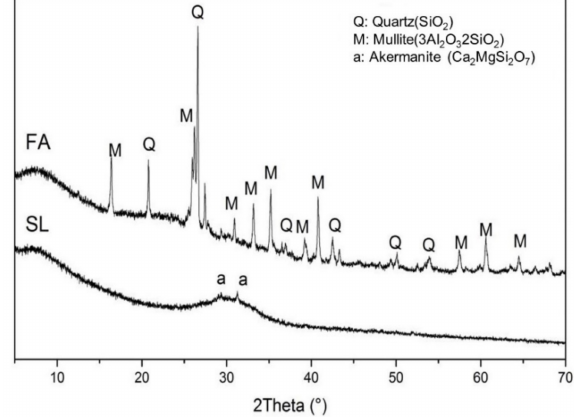
Figure 2. X-ray di ff raction analysis of the fly ash and the